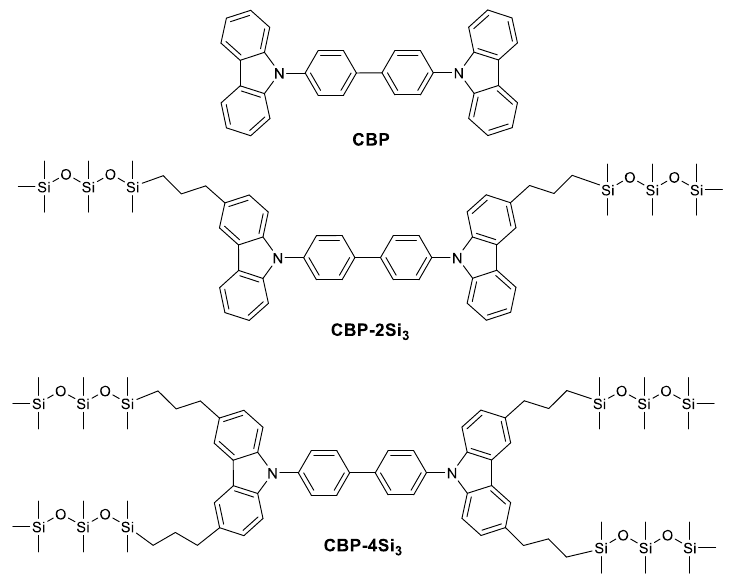
Figure 1. Molecular structures of CBP and siloxane-functionalized CBP derivatives .